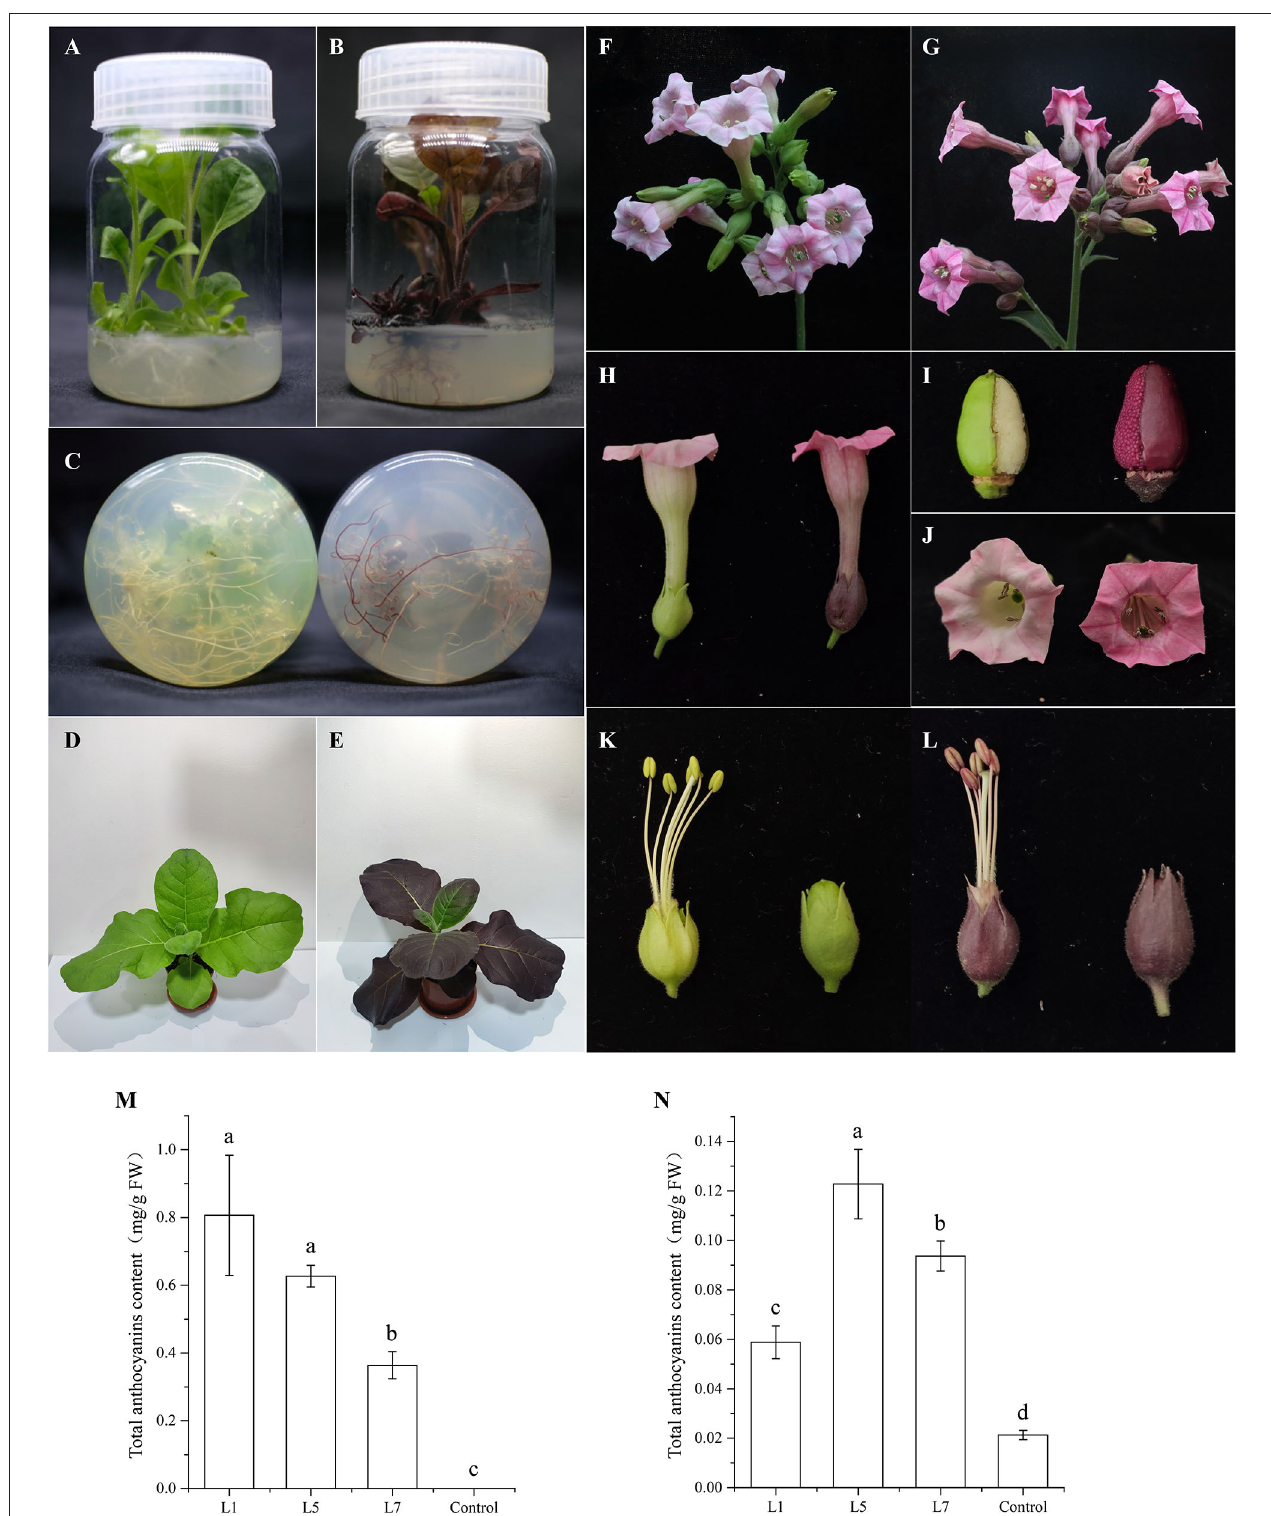
FIGURE 6 | Phenotypes and anthocyanin content of transgenic Nicotiana tabacum cv. NC89 plants overexpressing (OE)-AcMYB1 and empty vector controls. Culture seedling phenotypes of (A) control and (B) OE-AcMYB1 lines. (C) Root phenotypes of control (left) and OE-AcMYB1 (right) lines. Seedling phenotypes of (D) control and (E) OE-AcMYB1 lines. Flower phenotypes of (F) control and (G) OE-AcMYB1 lines. (H) corolla, (I) ovary wall, and (J) seed coat phenotypes of control (left) and OE-AcMYB1 (right) lines. Anther, filaments, and calyx phenotypes of (K) control and (L) OE-AcMYB1 lines. Anthocyanin content of leaves (M) and corollas (N) in OE-AcMYB1 lines L1, L5, and L7 and a control.